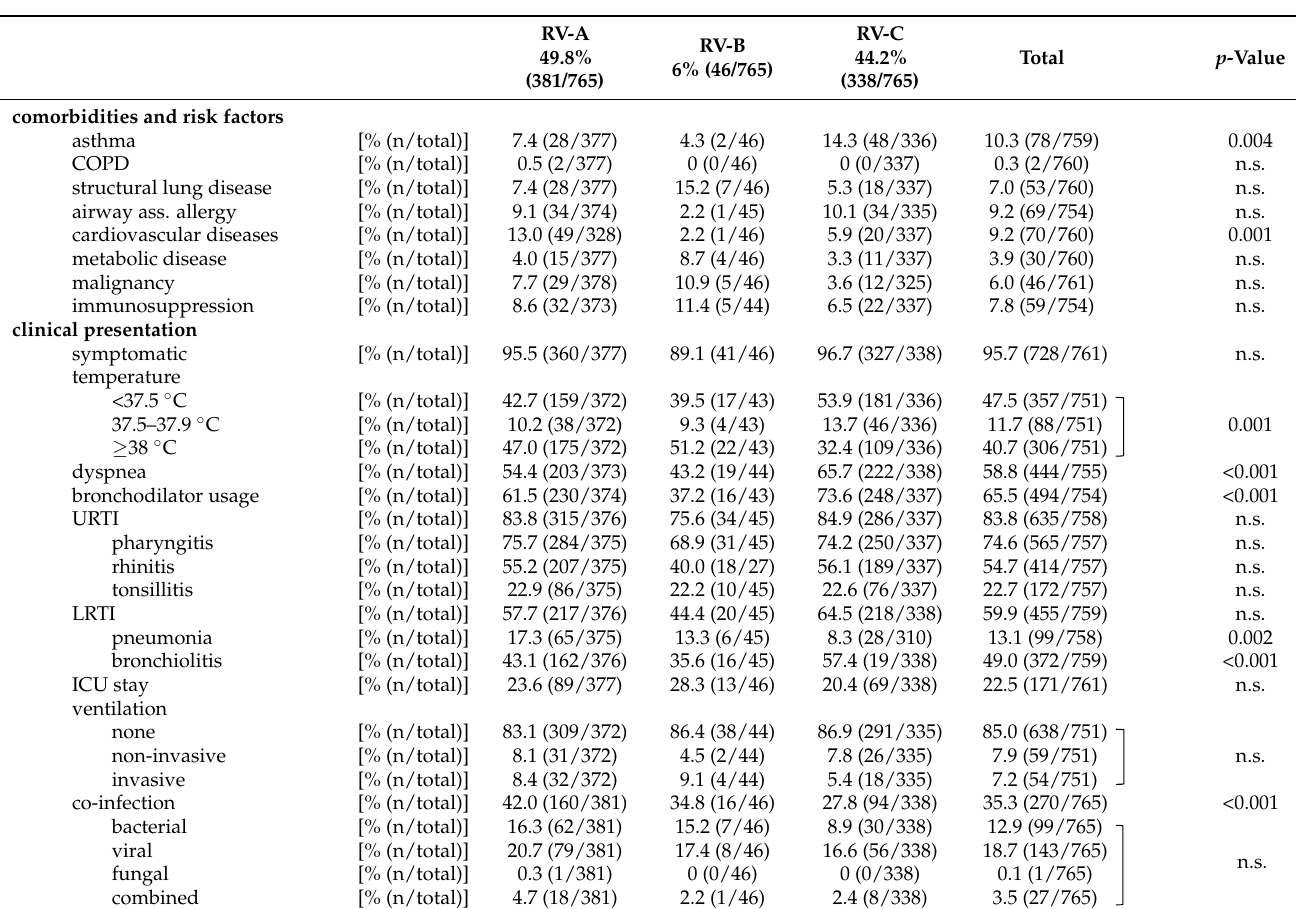
Table 2. Study population and clinical features of RV cases.